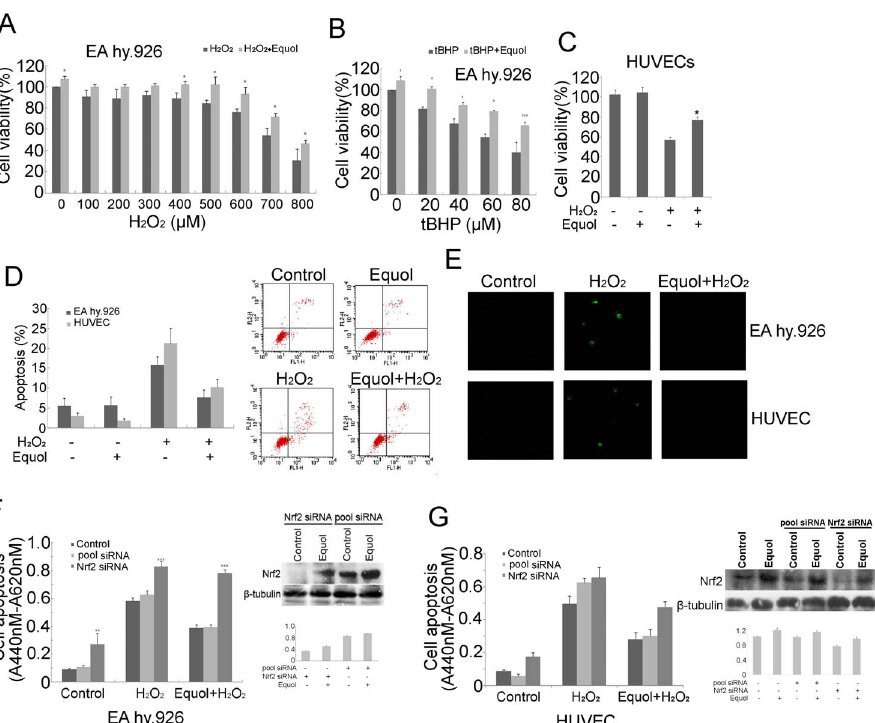
Figure 5. Efficacy of S- (-)equol in protecting against oxidative stress-induced toxicity through Nrf2. EA.hy926 cells that were pretreated with 100 nM S- (-)equol or sham treated for 24 h were exposed to H 2 O 2 (100–800 m M) (A) or tBHP (20–80 m M) (B) in the presence or absence of 100 nM S- (-)equol for 24 h. HUVECs were pretreated with 100 nM S- (-)equol or sham treated for 24 h were exposed to H 2 O 2 (100 m M) (C). Cell survival after oxidative stress was measured using a CCK-8 assay. The data are reported as the mean 6 SD, n=6. (D) Cells untreated or pretreated with 250 nM S- (-)equol for 24 h and then treated with H 2 O 2 for another 24 h. Apoptotic cell death was detected using Annexin V-FITC and flow cytometry. The mean 6 SD was calculated from three independent experiments. (E) Apoptotic cells were visualized by TUNEL. Immunoblot analysis showing Nrf2 protein in EA.hy926 cells (F, right) or HUVECs (G, right) transfected with a control or Nrf2-siRNA. Nrf2 protein was measured with immunoblot analysis using an anti-Nrf2 antibody to confirm knockdown of Nrf2 expression. (F and G) Untransfected cells and cells transfected with indicated siRNAs were incubated with 100 nM S- (-)equol for 24 h in the presence of 650 m M H 2 O 2 or with H 2 O 2 alone. The apoptotic index for each sample was determined using a cell death ELISA kit. The data are reported as the mean 6 SD, n=3 (* p , 0.05, ** p , 0.01, *** p , 0.001 compared with control group, # p , 0.05 compared with S- (-)equol treated group).